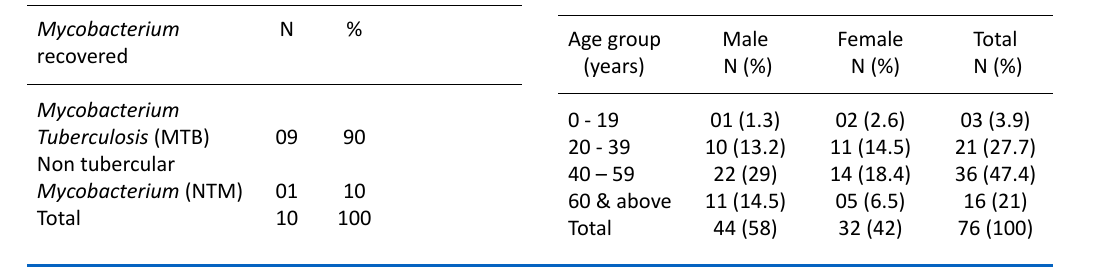
Fig 2. Gender-wise distribution of patients with suspected lesions table 2. Types of Mycobacterium recovered from positive samples